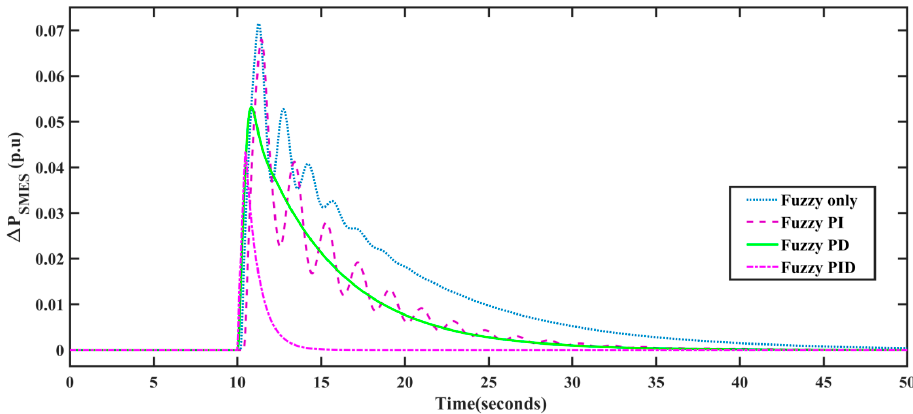
Figure 16. Dynamic response comparison of different control configurations of IHPS SMES power variation with step input of 10% increase in load.